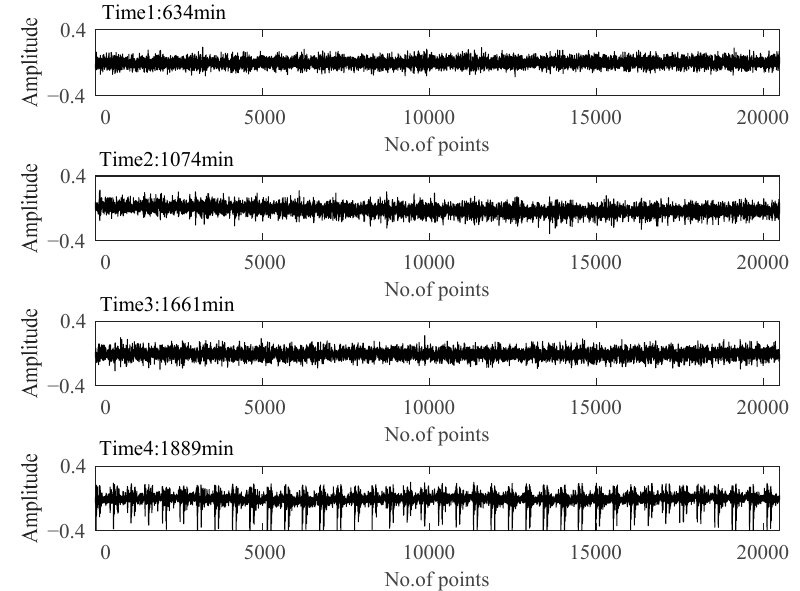
Figure 14. Time plots of four representative moments.